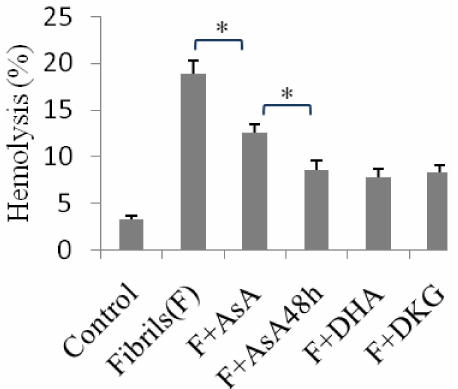
Figure 8. Hemolytic assay. Hemolysis of erythrocytes was induced by incubation of (37 ◦ C) cell suspensions (1%, v / v ) with insulin assemblies for 3 h. Insulin assemblies were prepared by incubation of mature fibrils at 37 ◦ C for 3 h in the absence or presence of AsA and its degradation products. * represents p < 0.05 (n =